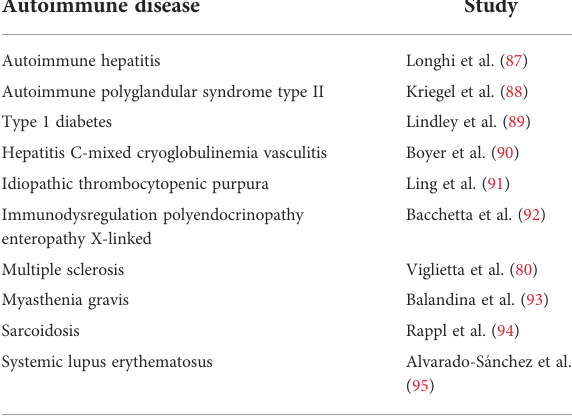
TABLE 1 Impaired Treg function in autoimmune diseases.